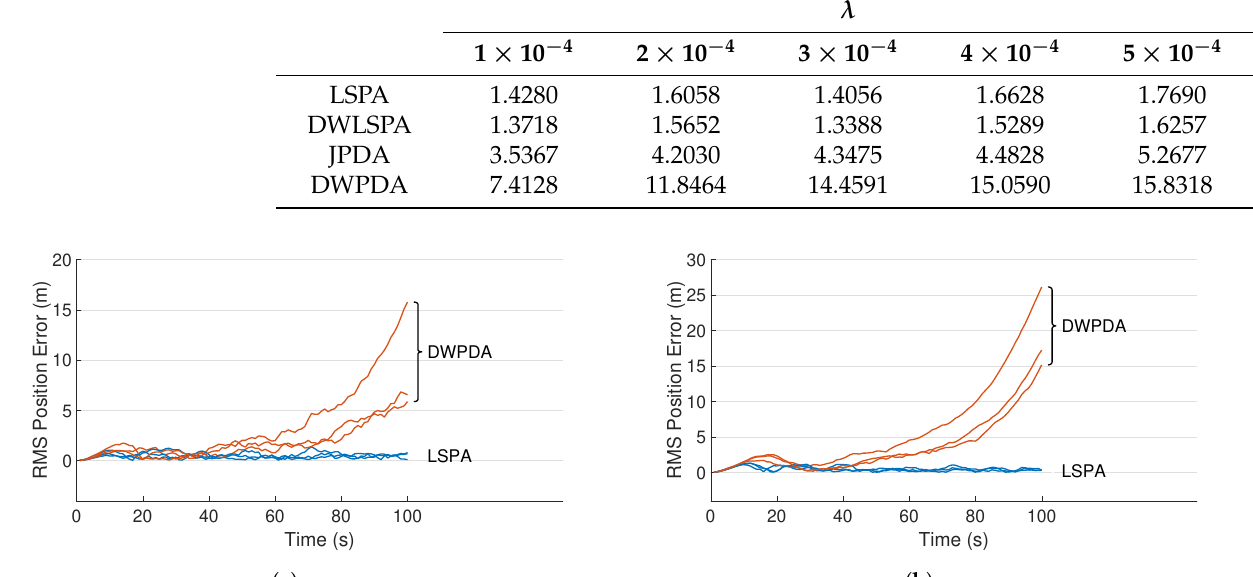
Figure 4. RMS position error for three crossing targets using DWPDA and LSPA with different clutter densities. ( a ) Clutter density λ = 1 × 10 − 4 /m 2 ; and ( b ) clutter density λ = 5 × 10 − 4 /m 2 .